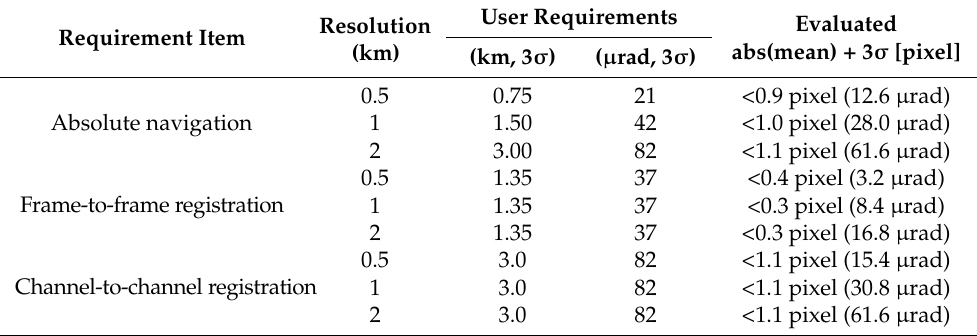
Table 6. Required and on-orbit validation of channel navigation residuals for GK2A AMI. The residual is bias plus three standard deviations (confidence level 99.73% (3 σ